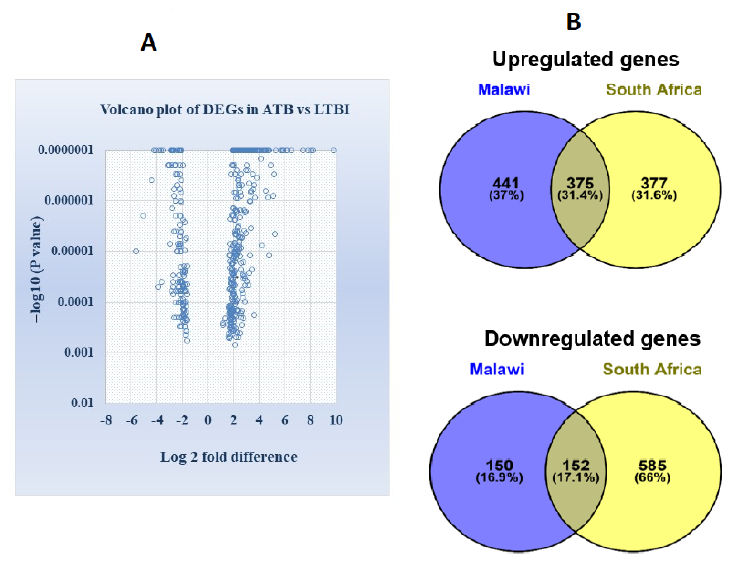
Figure 1. ( A ) Volcano plot illustrating the identification of differentially expressed genes between ATB and LTBI in the Malawi and South African cohort (differentially expressed genes were distin- guished with parameter −log10 p value in y axis and log2 fold change in x axis). Significant results were determined based on cut off range, p value < 0.01 and >1.5-fold change ( B ) Venn diagram demonstrating the intersection of differentially expressed overlapped or common genes, in Malawi and South African cohort derived from GSE37250 (Figure S1).